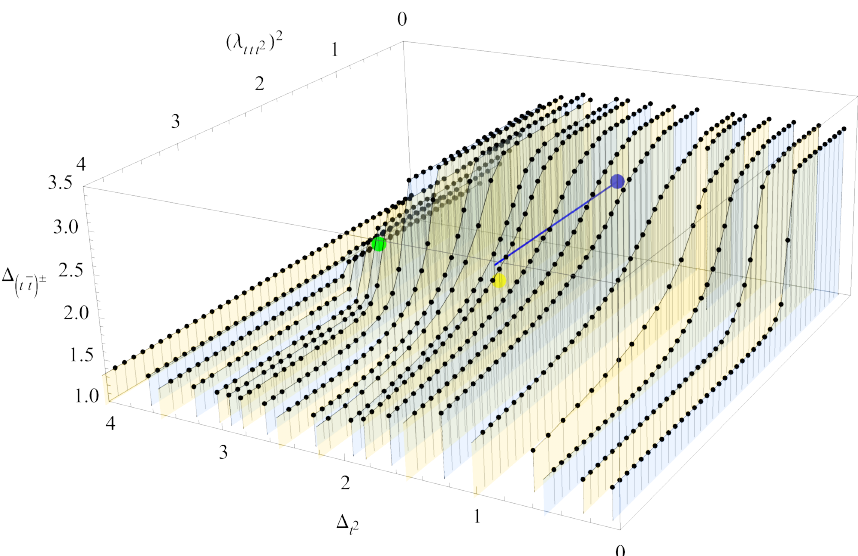
Figure 4. Bounds on the dimension of the first singlet in the t × ¯ t OPE as a function of the gap on the dimension ∆ and the OPE coefficient ( λ ) 2 of the first operator charged under O(2) F t 2 ttt 2 in the t × t OPE. The gaps on the dimension of the parity-even and -odd operators are set to be equal. The free theory solutions GFF (green), GFB (blue), and their interpolation (blue), presented in eqs. (2.19) and (2.20) are also shown, as is the ε -expansion result for the magnetic line defect discussed in section 3.2 (yellow). Λ = 49 , P = 69